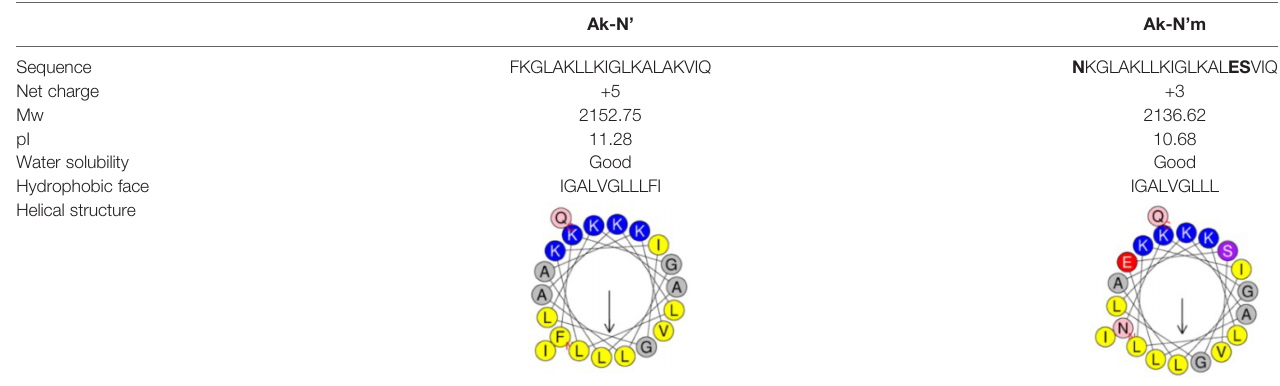
TABLE 2 | Physiochemical properties of Ak-N ’ and Ak-N ’ m